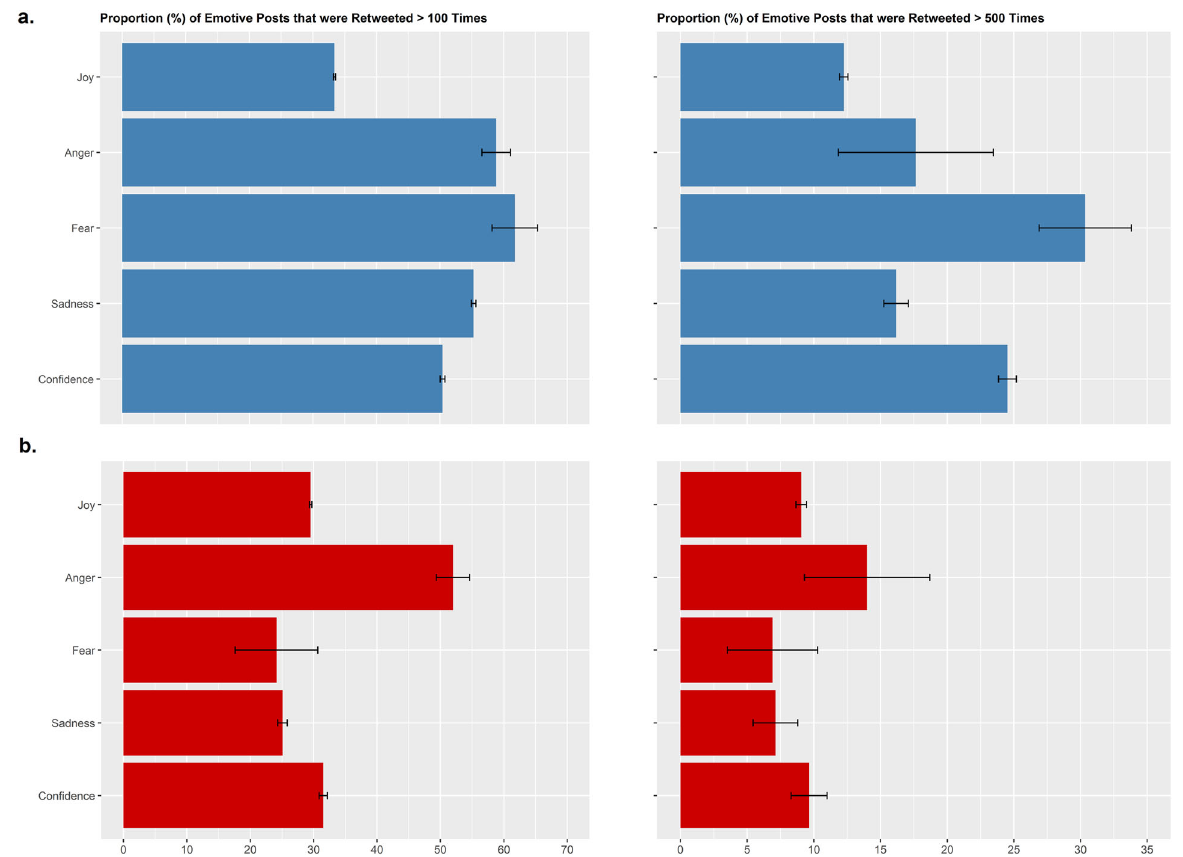
Fig. 1 Retweeting rates of emotionally charged messages. Retweeting rates of messages containing emotional content published by a Democratic vs. b Republican candidates. Error bars are derived to estimate the proportion between the upper and lower limits (proportion ± standard